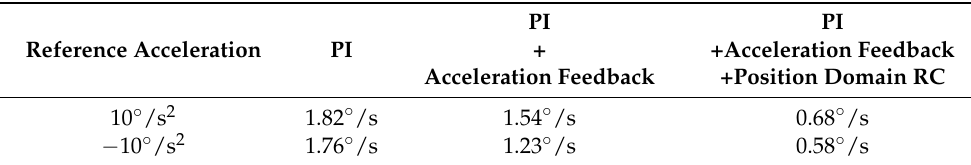
Table 6. The peak-to-peak speed at variable speed motion.